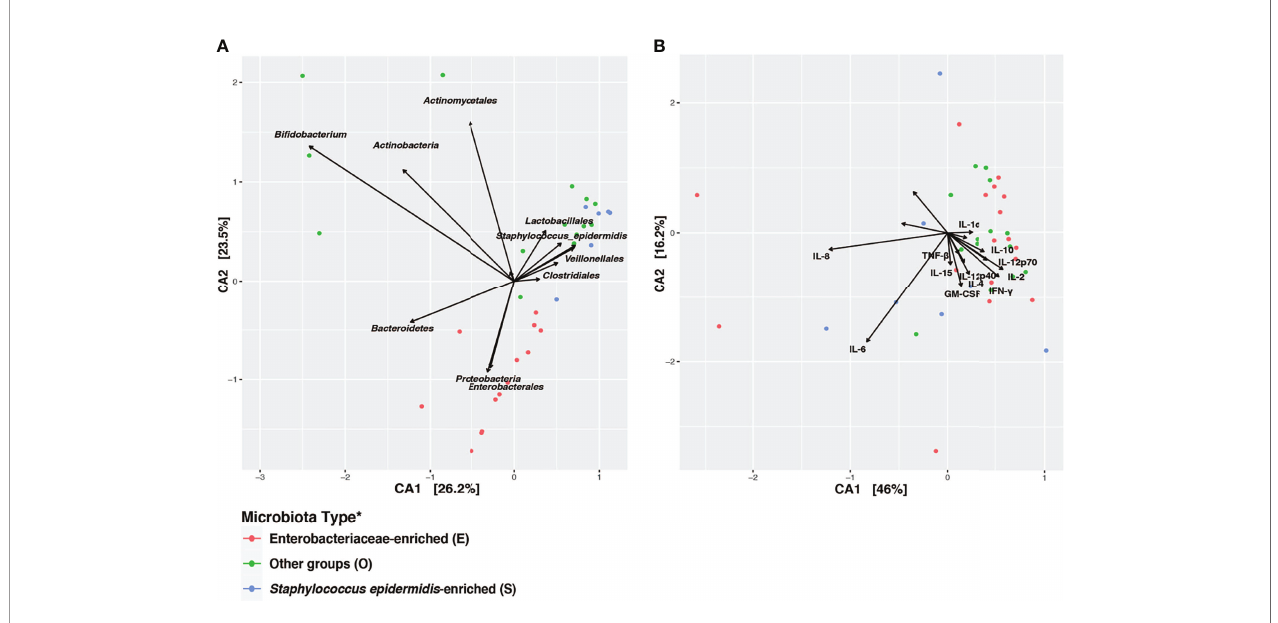
FIGURE 4 | Disparity in clustering patterns of taxonomic and immunological pro fi ling among different microbiota types. Canonical Correspondence Analysis (CCA) of (A) microbial taxonomic groups; (B) cytokine pro fi les. CCA was based on Bray-Curtis distance. CA1 and CA2 selected as the major components based on the eigenvalue. A scaled eigenvalues was shown on the plot to represent the direction from the origin where a group has a larger than average value for the particular pro fi le (42, 51). *Microbiota type was assigned according to the clustering pattern demonstrated in Figure 1 .